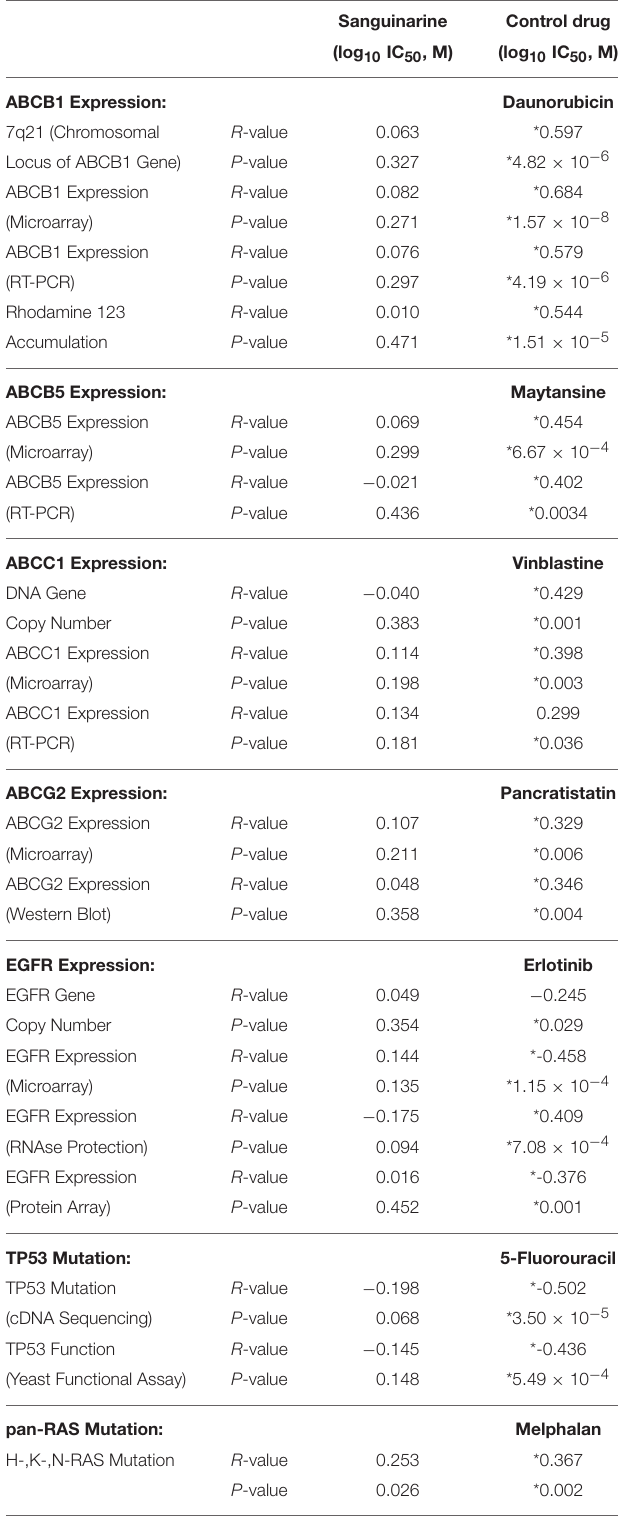
TABLE 1 | Correlation of log 10 IC 50 values for sanguinarine to drug resistance mechanisms (ABCB1, ABCB5, ABCC1, ABCG2, EGFR, TP53, pan-RAS) in the NCI cell line